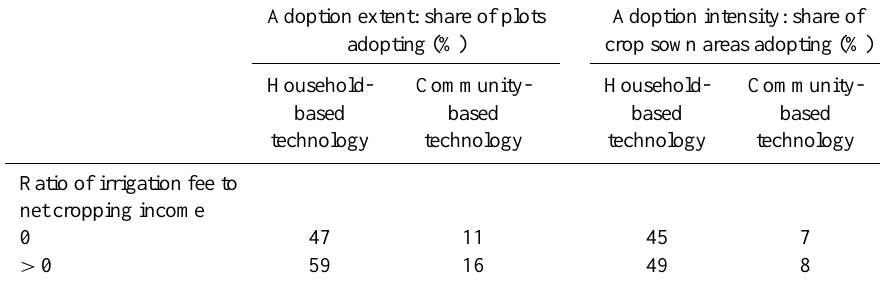
Table 4. Relationship between economic incentives and adoption of modern irrigation technology in China, 2010. Adoption extent: share of plots Adoption intensity: share of adopting (%) crop sown areas adopting (%) Household- Community- Household- Community- based based based based technology technology technology technology Ratio of irrigation fee